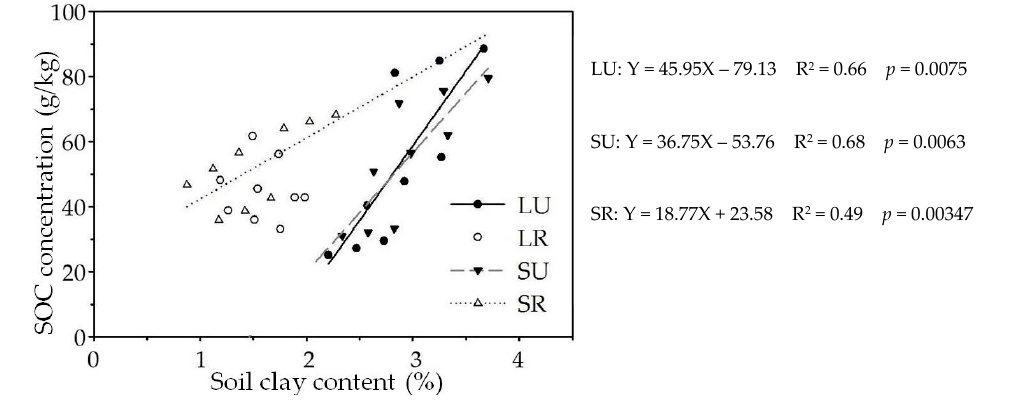
Figure 4. Relationship between soil organic carbon (SOC) concentration and soil clay content in the four soil profiles (LU, LR, SU and SR) in a montane sub-tropical moist forest of southwestern China.